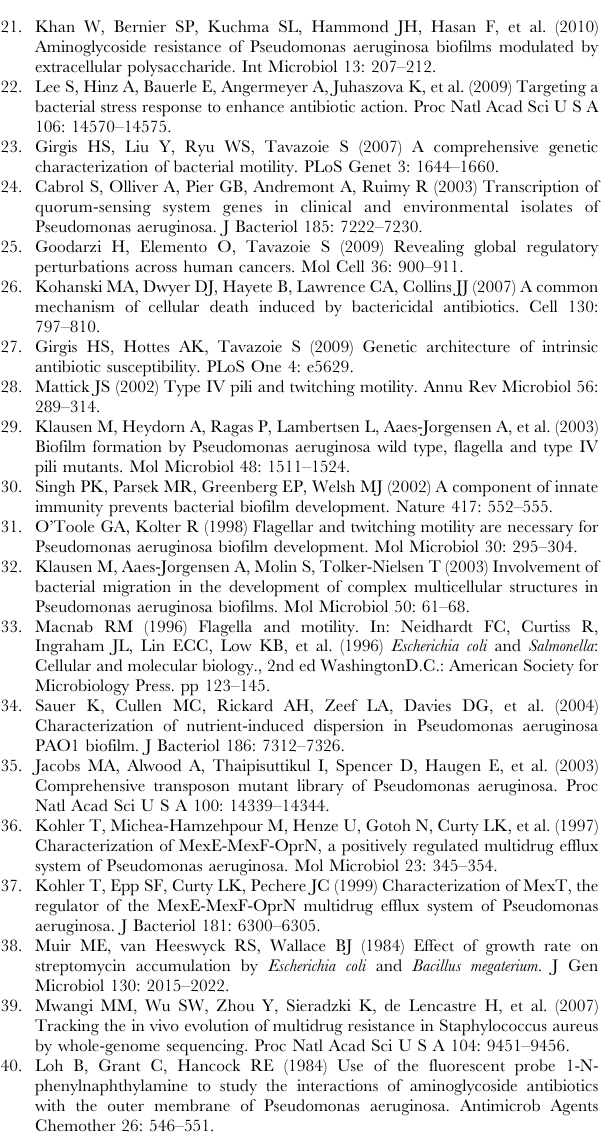
Protocol S1 A more detailed description of the protocols and methods. Table S1 Strain table. List of all strains used in this study.